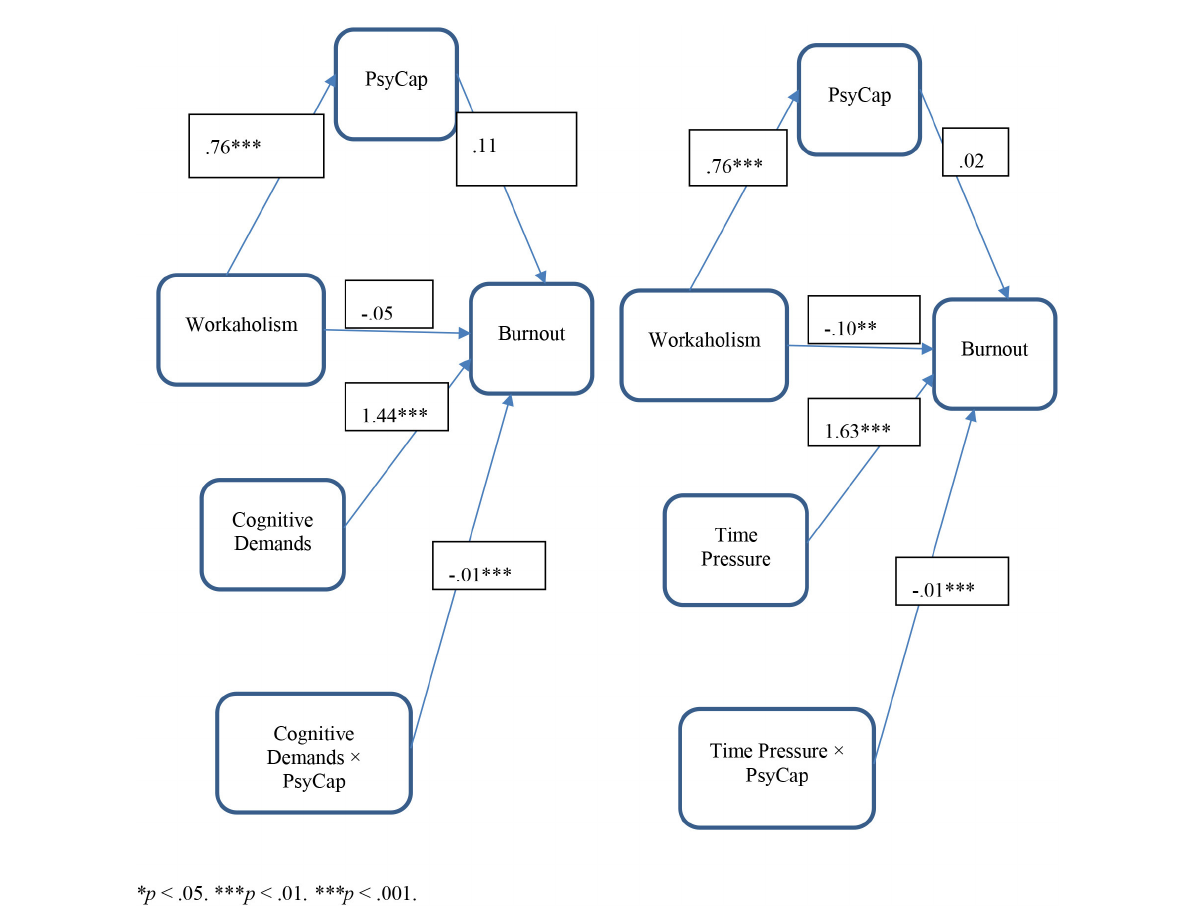
FIGURE4 Relationship of workaholism and job burnout mediated by PsyCap and moderated by time pressure and cognitive demands ( N =